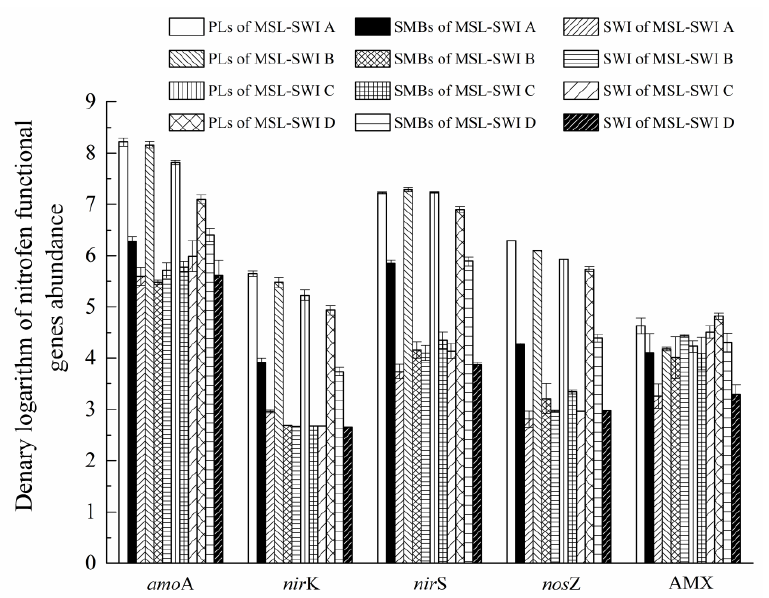
Figure 5. The abundance of nitrogen functional genes in PLs, SMBs, and SWI sections in four MSL-